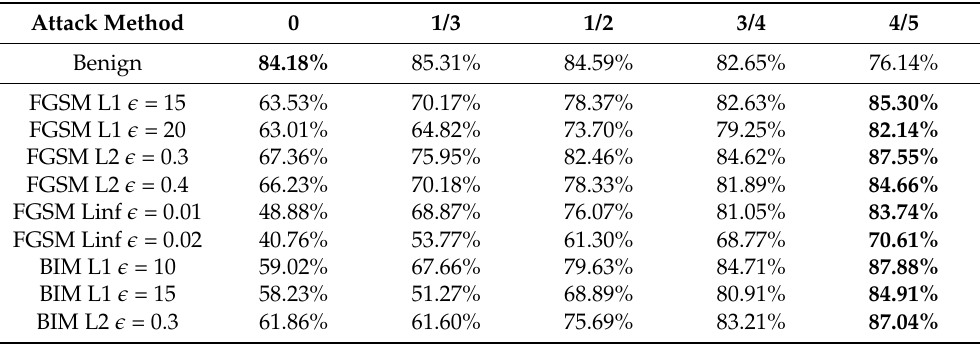
Table 1. Defense of different mask rates with the grid size of 8 × 8 for the training phase and 4 × 4 for the test phase, on a VGG16 model with CIFAR-10